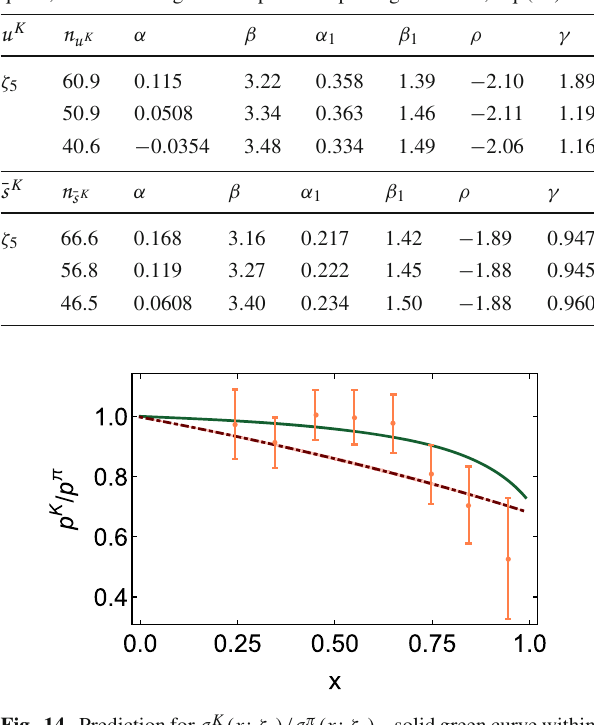
Fig. 14 Prediction for g K ( x ; ζ 5 )/ g π ( x ; ζ 5 ) – solid green curve within green shading; and for S K ( x ; ζ 5 )/ S π ( x ; ζ 5 ) – dot-dashed red curve within red shading. (The uncertainty introduced by that in the k 2 = 0 value of the PI charge, Fig.1, is indicated by the shaded band bracketing each curve. In both cases here, that band is no thicker than the width of the central line.) Data on u K ( x ; ζ 5 )/ u π ( x ; ζ 5 ) (orange) from